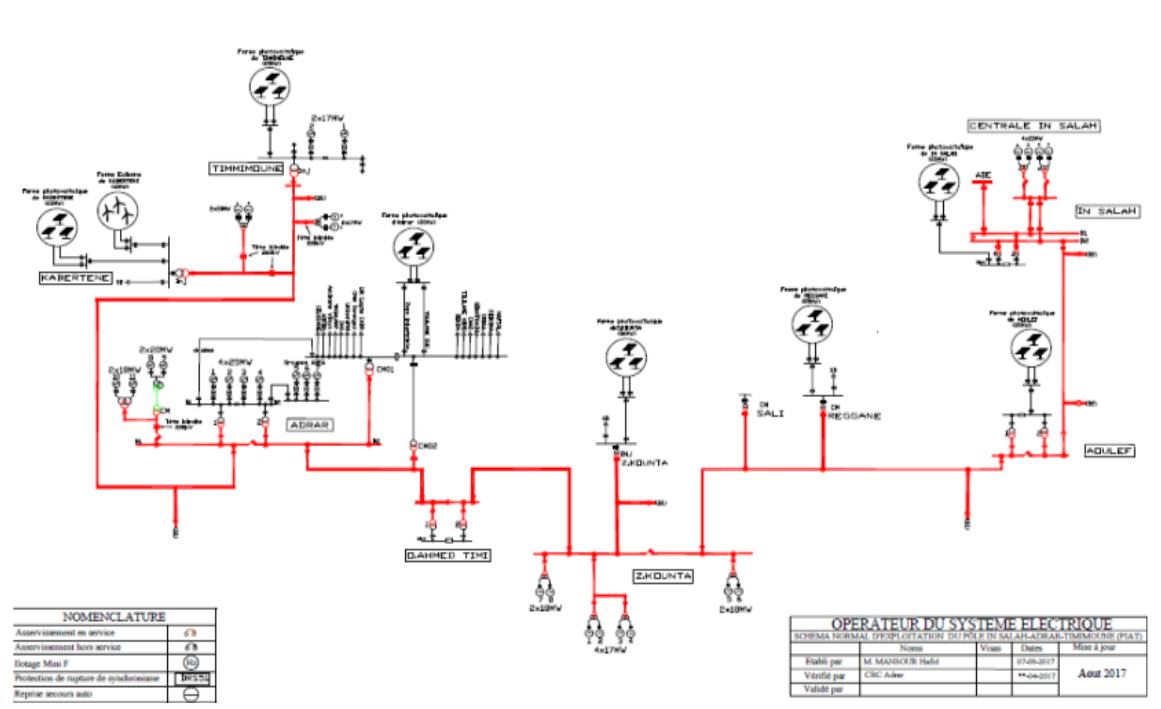
Figure 8. PIAT grid operational diagram, SKTM, 2017